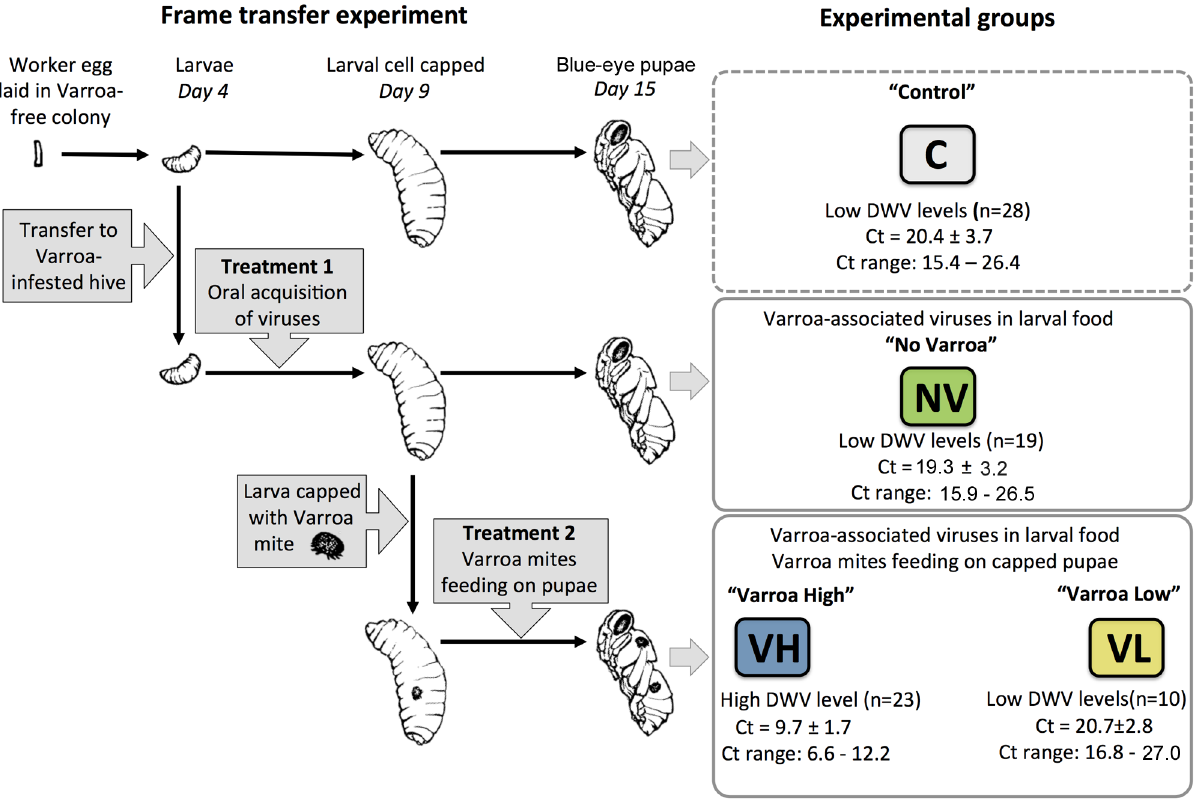
Figure 1. Design of the frame transfer experiment, summary of treatments, and experimental honeybee groups. Shown are treatments of the experimental groups of honeybees originated in a single colony, number ( n ) of individuals, and the results of DWV-like virus quantification in the individual pupae by real-time PCR (average Ct value 6 standard deviation (SD) and the range of Ct values).